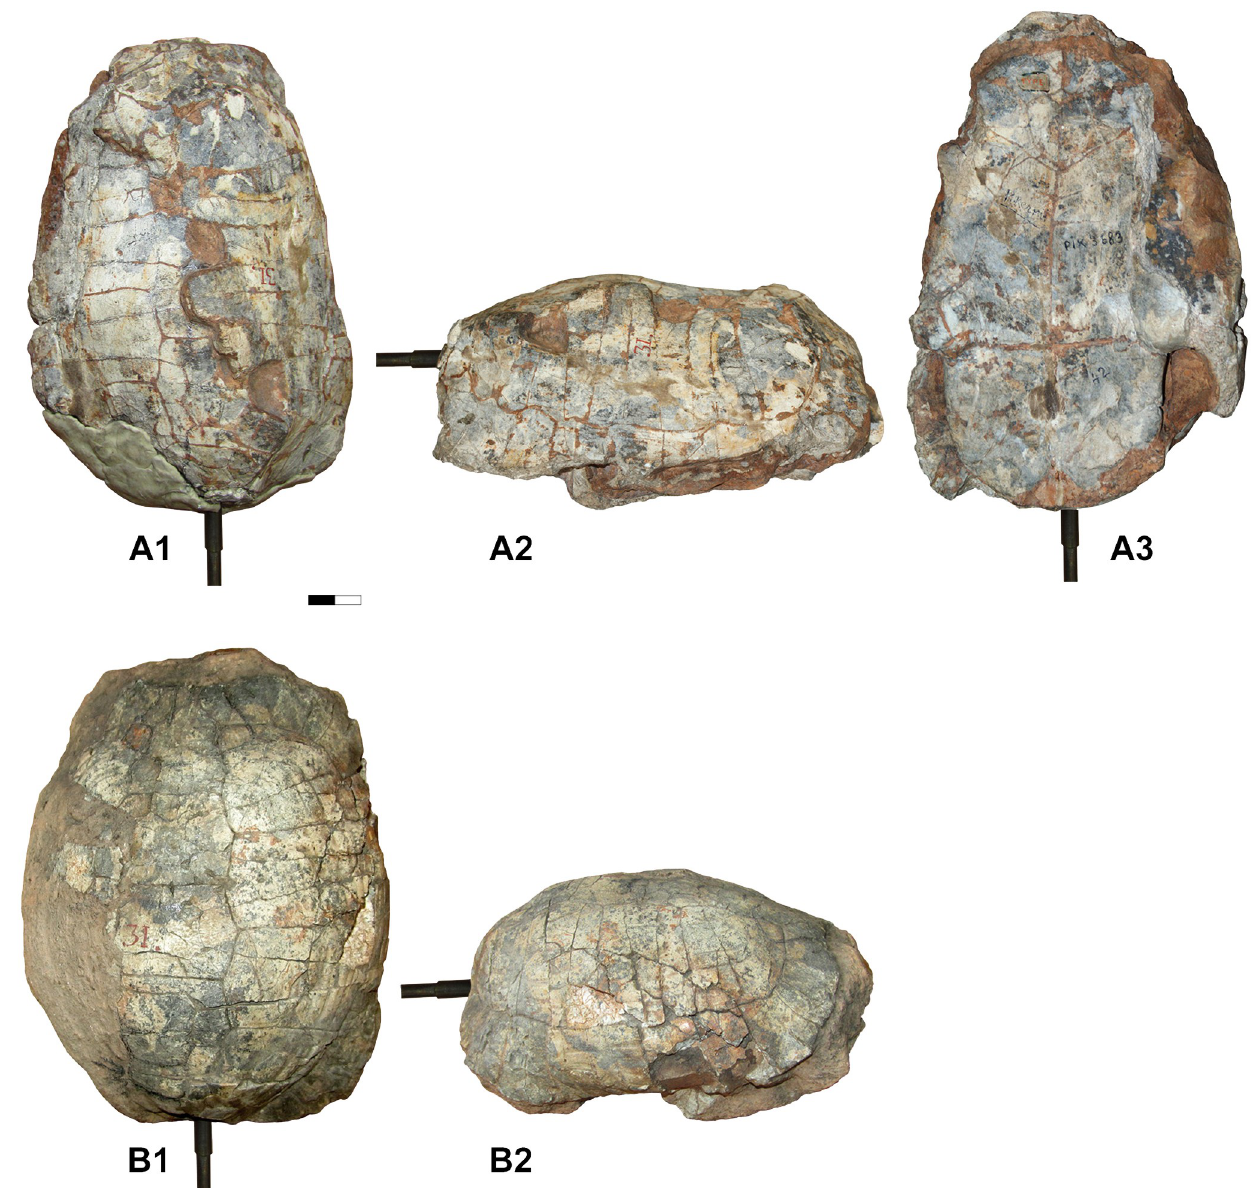
Fig 5. Testudo marmorum from Pikermi (Greece, late Miocene) described by Gaudry in 1862, 1862–1867. Holotype MNHN F 1862-67(42) PIK 3683, Carapace in dorsal (A1), lateral (A2) and ventral views. Specimen MNHN F 1862-67(43), Carapace in dorsal (B1) and lateral (B2) views. No plastron is preserved in this